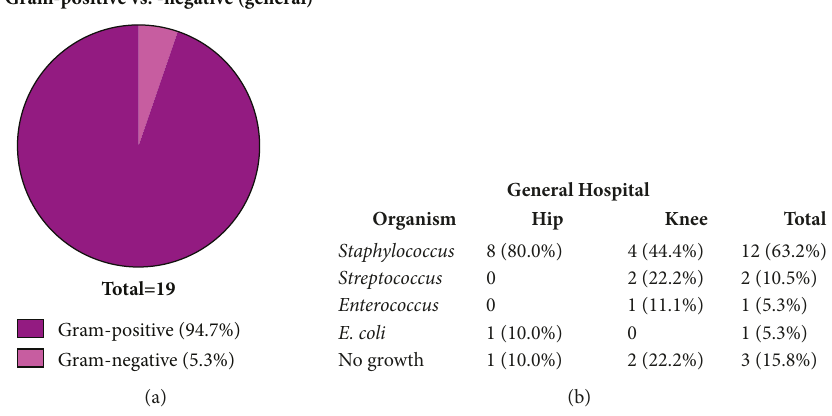
Figure1: Atgeneraluniversityhospital,amajorityofinfectionsarecausedbyGram-positiveorganisms. (a)Thepercentagesofisolatedorganisms that were Gram-negative, Gram-positive, or neither or experienced no growth were examined at the general university hospital. (b) The bacterial organisms in hip and knee PJIs at the general university hospital were characterized.